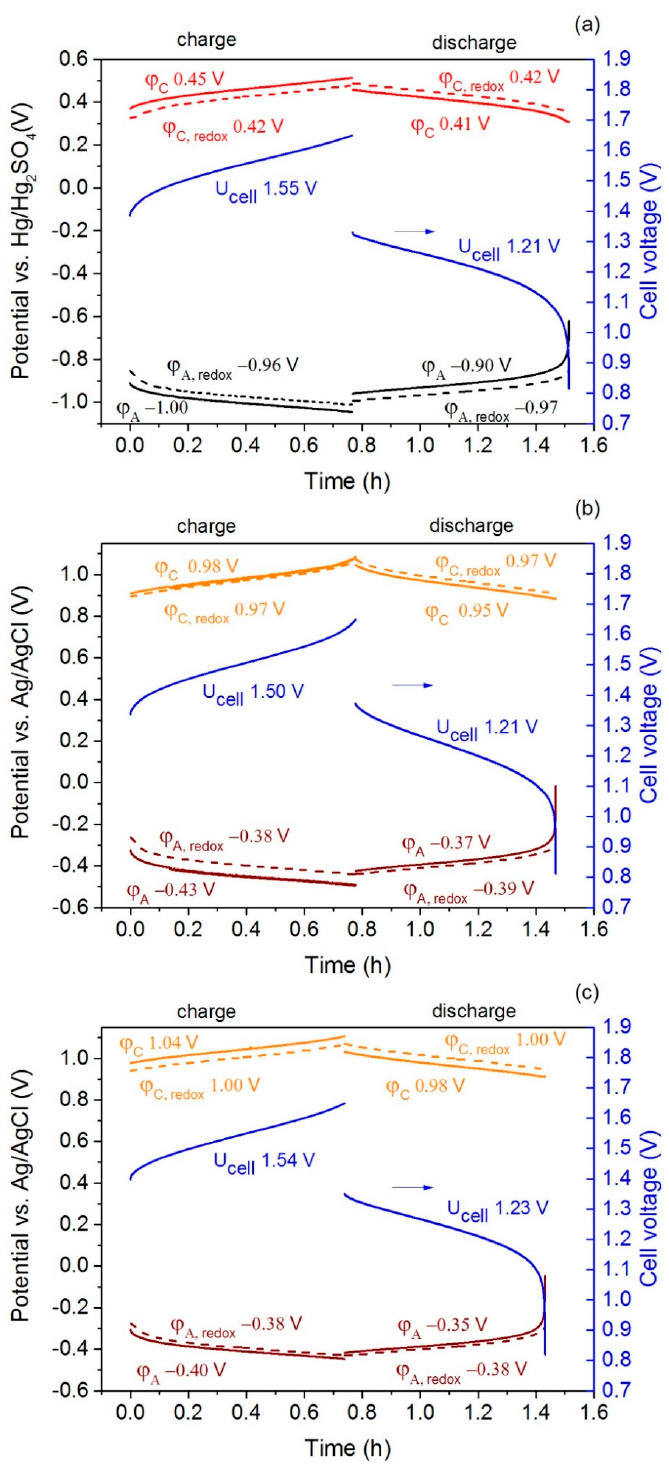
Figure 3. Charge-discharge curves for cells operated with ( a ) I-V3.5- H 2 SO 4 , ( b ) I-V3.5-HCl, and ( c ) II-V3.5-HCl electrolytes at a current density of 50 mA ∙ cm − 2 . Cell voltage curves (blue lines), cathodic φ C and anodic φ A half-cell potentials (solid lines), cathodic φ C, redox and anodic φ C, redox redox potentials (dashed lines).